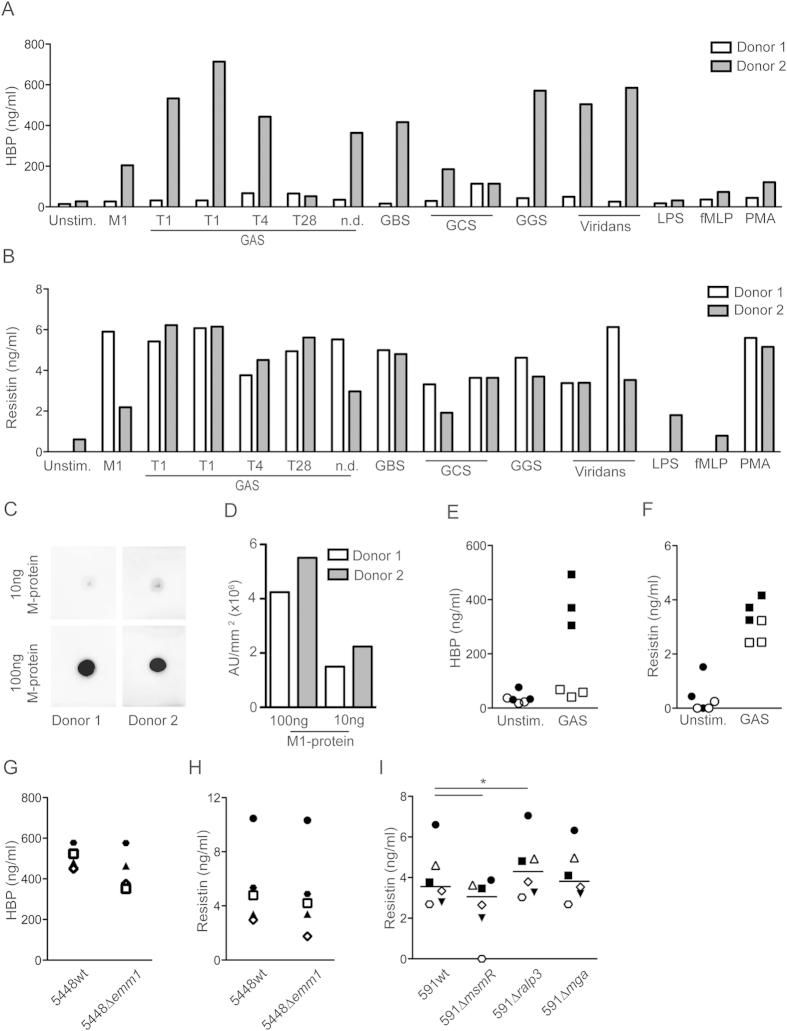
Pronounced neutrophil stimulatory effect can be seen across streptococcal species and involves multiple surface proteins.(A,B) HBP and resistin levels in supernatants from neutrophils isolated from two donors (D1 and D2) stimulated with different fixed streptococcal species (67 cfu/cell), as indicated in the figure. ND denotes serotype not determined. (C) Plasma from the high- and low responding donor (D1 and D2) was tested for anti-M1 protein antibodies by dot blot analyses. Purified M1-protein (100 and 10 ng) was spotted on to a PVDF-membrane, after which donor plasma was added and incubated over night. Bound anti-M1 antibodies were detected using HRP coupled anti-human IgG. (D) The intensity of positive stain was quantified and plotted as arbitrary units (AU)/mm2. (E,F) HBP and resistin levels in culture supernatants from neutrophils, either unstimulated (Unstim.) or stimulated with fixed GAS T1 (GAS), in the presence (filled symbols) or absence (open symbols) of 10% autologous plasma. The experiment was done using cells from three different donors. (G,H) HBP and Resistin levels in culture supernatants from neutrophils stimulated with fixed wild type or corresponding isogenic deletion mutants of the emm1 gene. Shown are the results from 4–5 experiments using different donors, indicated by specific symbols. (I) Resistin levels in culture supernatants from neutrophils stimulated with fixed wild type or corresponding isogenic deletion mutants of the indicated genes. Results were obtained from five experiments using different donors, the respective donors are indicated by specific symbols and the line indicates median. Wilcoxon matched-pairs signed rank test was used for comparison between groups, *P < 0.05.